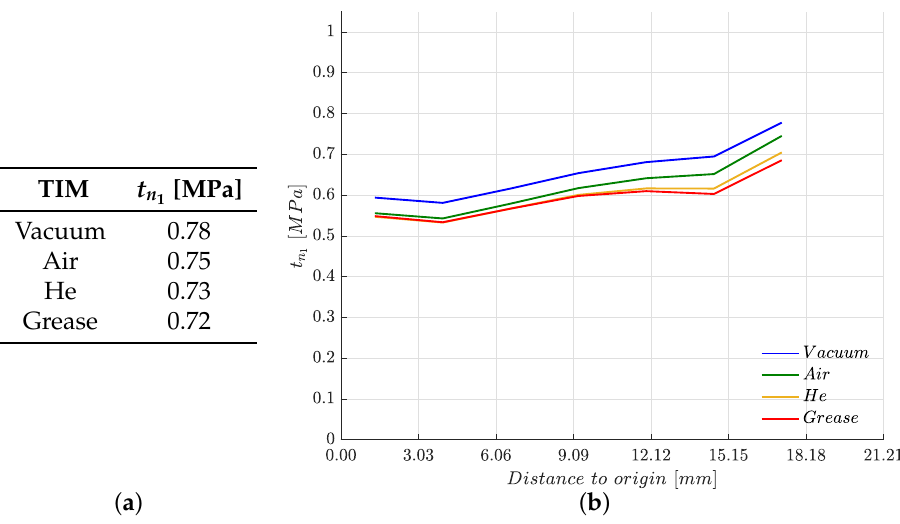
Figure 13. ( a ) Median normal contact traction value comparison at the potential contact zone. ( b ) Normal contact traction distribution comparison at the nodes located at the diagonal of the contact